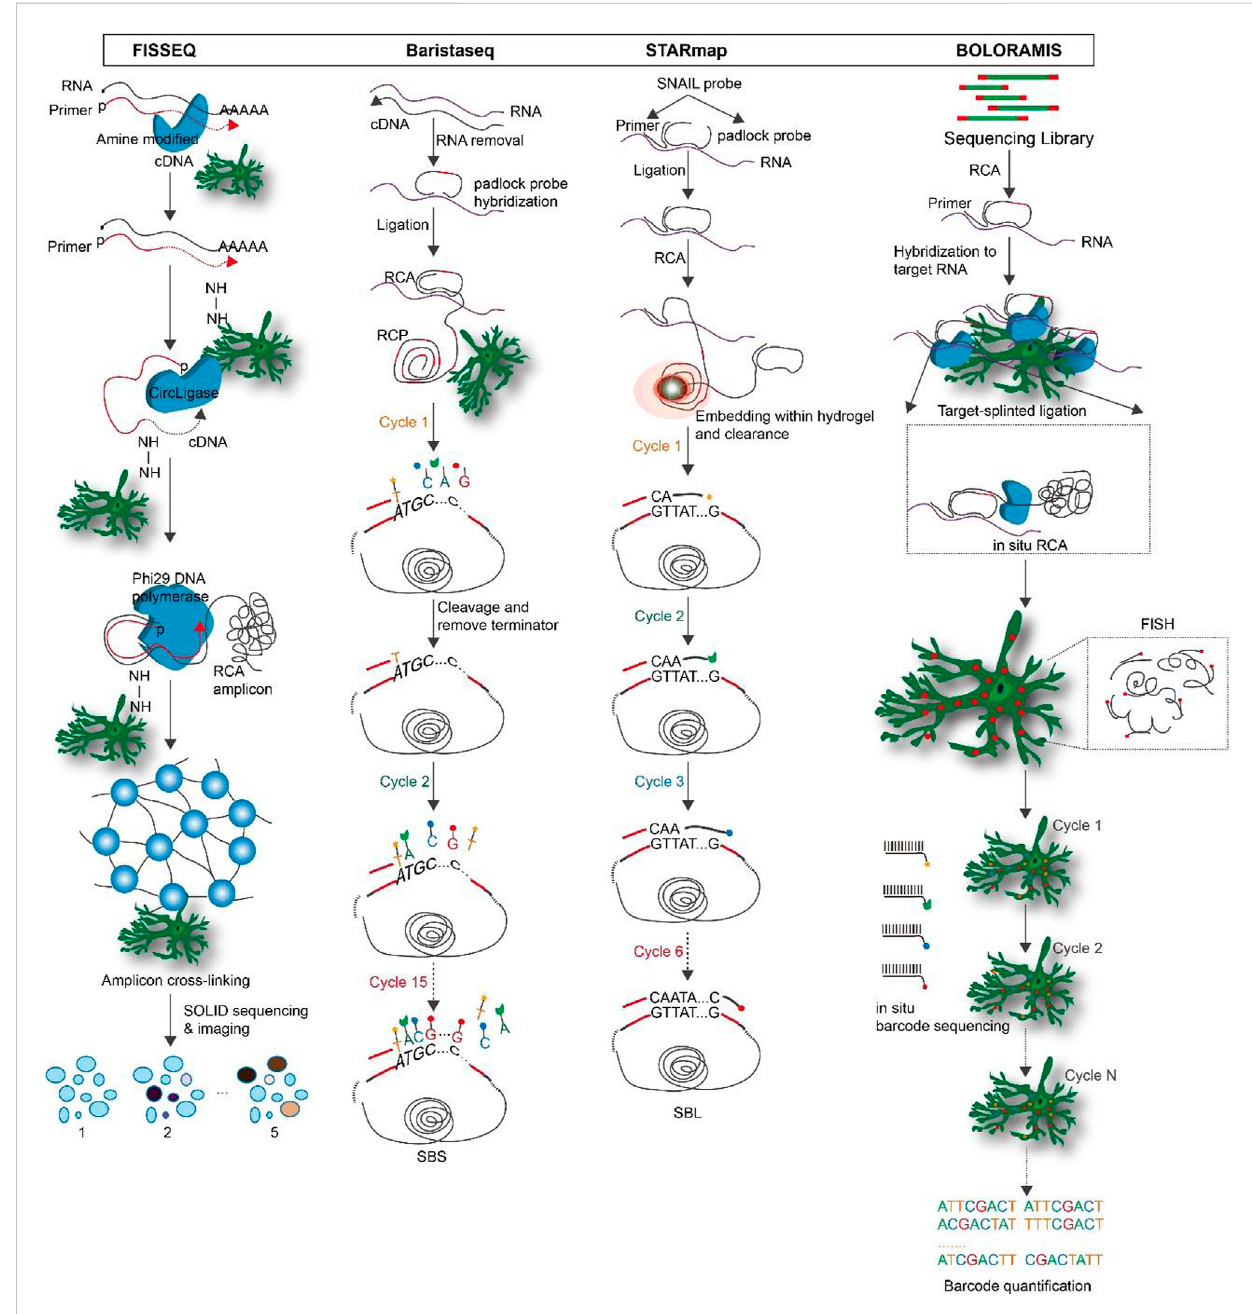
FIGURE 3 The overview and principle of spatial transcriptome technologies based on in situ hybridization.